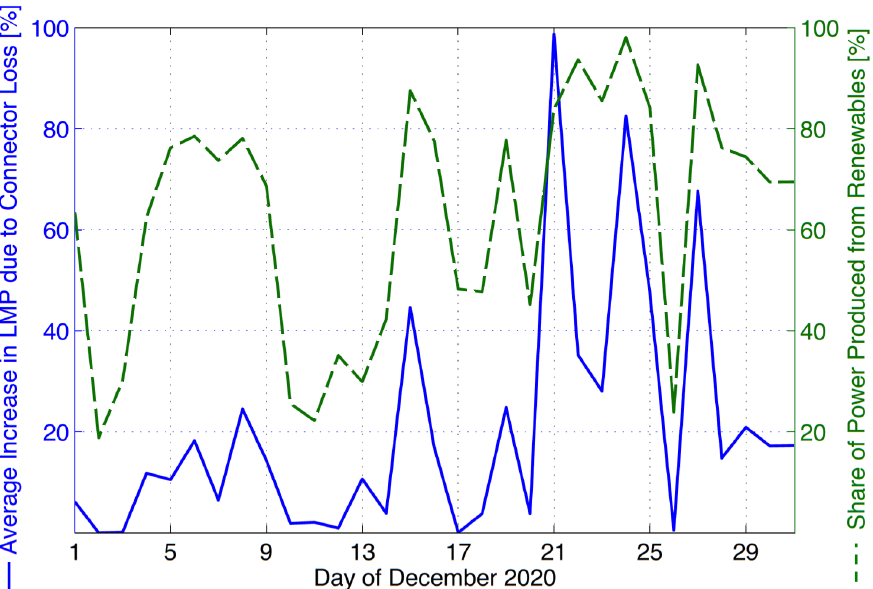
Figure 12. Average relative change in prices as function of renewables generation in Germany due to disconnection of 3.25 GW offshore